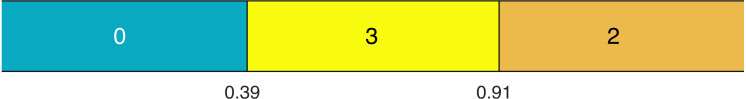
An example of a main effect with points for each interval indicated by colours and numbers.The thresholds τ are visible at the interval boundaries.